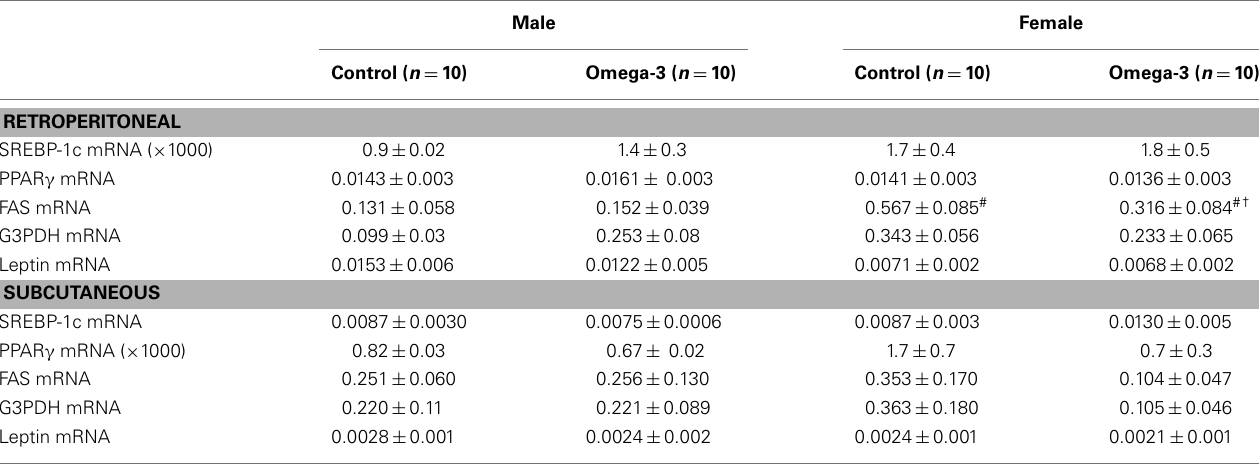
Table 6 | Expression of adipocyte genes in retroperitoneal and subcutaneous adipose tissue at 6weeks of age in offspring of Control and Omega-3 dams (normalized to β